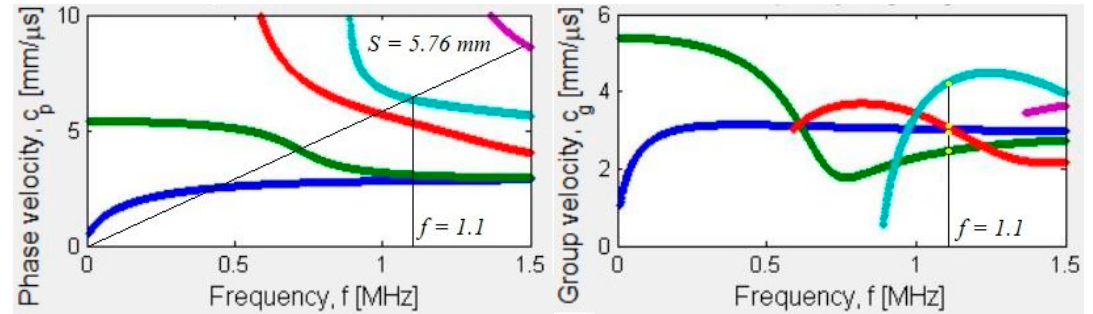
Figure 17. Dispersion curves for a 3.2 mm thick aluminum 6061 plate showing the activation line on the phase velocity and corresponding group velocities at that frequency [82].